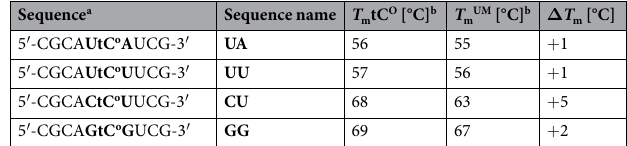
Table 1. Melting temperatures of tC O -containing RNA duplexes ( T m tC O ), the corresponding unmodified duplexes ( T mUM ) and the difference in melting temperature as a result of changing one C for tC O ( Δ T m ). a In unmodified sequences, tC O is replaced by cytosine. b Measurements were performed in PBS buffer (100 mM Na + , pH 7.5). T m values were determined as the average of the temperature values at the maximum of the first derivative and at half maximum of the melting curves.